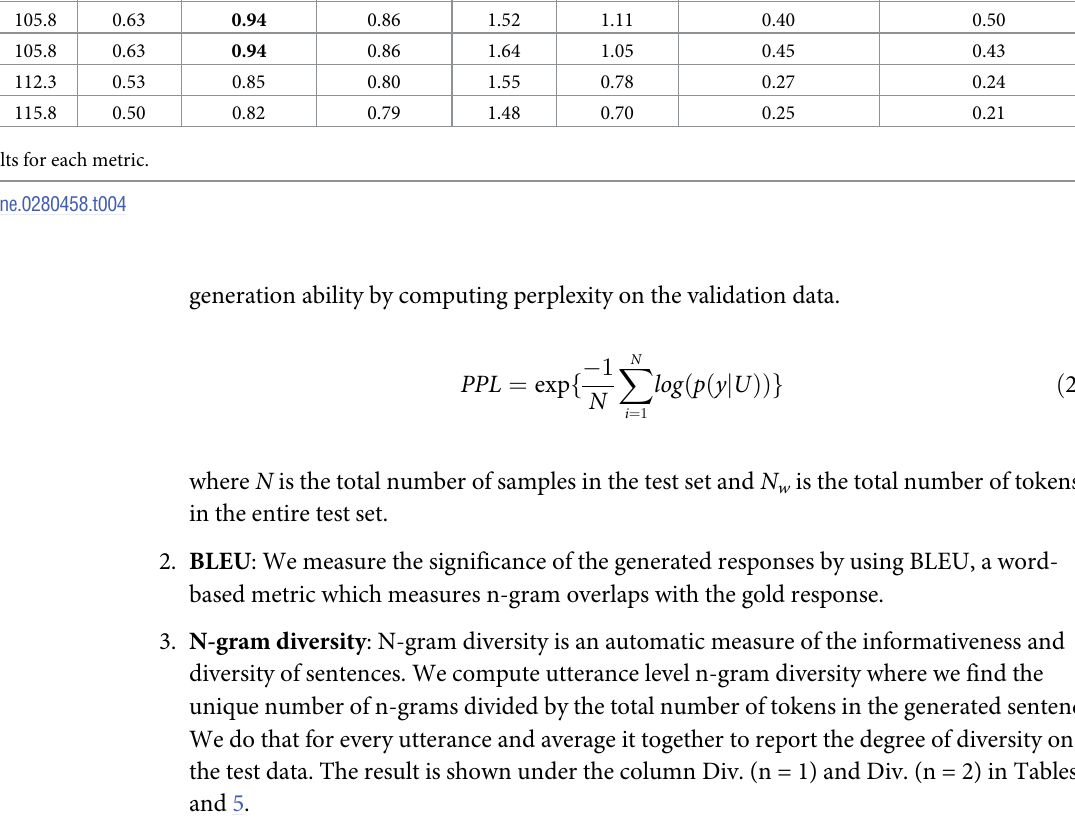
EmpTransfo EmoKbGAN